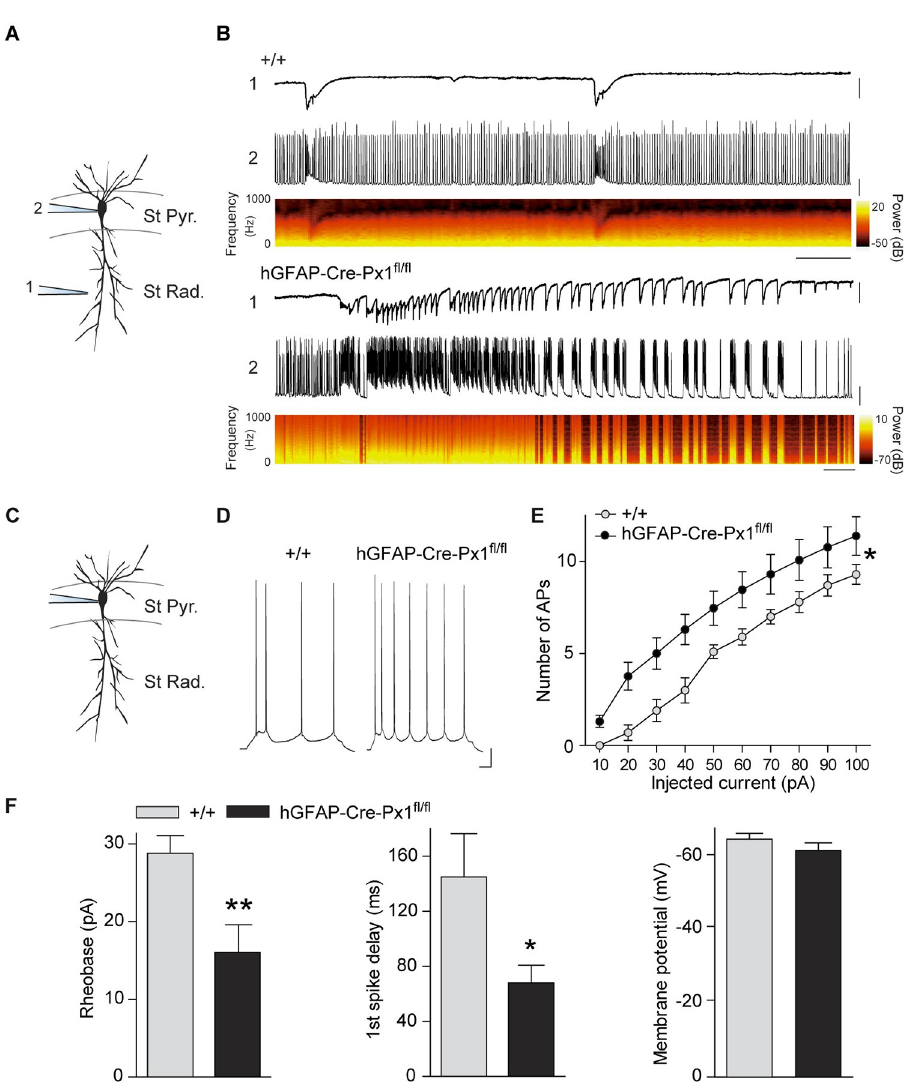
Fig 4. Pyramidal cells from astroglial Px1-deficient mice are more excitable. ( A ) Schematic illustration of simultaneous recording of fEPSP (1) and single neuron (2) in the hippocampus. St Pyr., Stratum Pyramidale ; St Rad., Stratum Radiatum . ( B ) Representative traces of fEPSP (1) and single neuron spontaneous activity (2) in +/+ mice (upper traces) or hGFAP-Cre-Px1 fl/fl mice (lower traces). The time-frequency plots corresponding to single neuron recordings are shown under the traces. Scale bar: +/+, 2 s; hGFAP-Cre-Px1 fl/fl , 5 s; fEPSP, 0.2 mV; single neuron, 20 mV. ( C ) Schematic illustration of single neuron recording in CA1 hippocampal area. ( D ) Representative traces of CA1 pyramidal cell firing pattern from +/+ and hGFAP-Cre-Px1 fl/fl mice in basal ACSF containing synaptic blockers (picrotoxin 100 μ m, NBQX 10 μ M, CPP 10 μ M) during depolarisation by 10 pA injection for 500 ms. Cells were held at − 60 mV. Scale bar: 50 ms, 10 mV. ( E ) Number of APs evoked by current injection from 10 pA to 100 pA (+/+, n = 10 neurons from 5 mice; hGFAP-Cre-Px1 fl/fl , n = 13 neurons from 5 mice; two-way ANOVA and multiple comparisons test). ( F ) Quantification of rheobase, time to first spike and membrane potential, (+/+, n = 10 neurons from 5 mice; hGFAP-Cre-Px1 fl/fl , n = 14 neurons from 5 mice; unpaired Student t test). Asterisks indicate statistical significance ( � p < 0.05, �� p < 0.01). The data underlying this figure can be found in the S1 Metadata D tab. Px1 fl/fl mice, and found that ATP extracellular levels, measured using a luciferin–luciferase assay (Fig 5A, left panel), significantly increased during bursting activity compared to basal conditions in +/+ mice (Basal: 1.07 ± 0.33 nM, Population activity: 2.55 ± 0.61 nM; n = 7 mice; p = 0.026; Fig 5A, right panel). Notably, slices from hGFAP-Cre-Px1 fl/fl mice displayed a